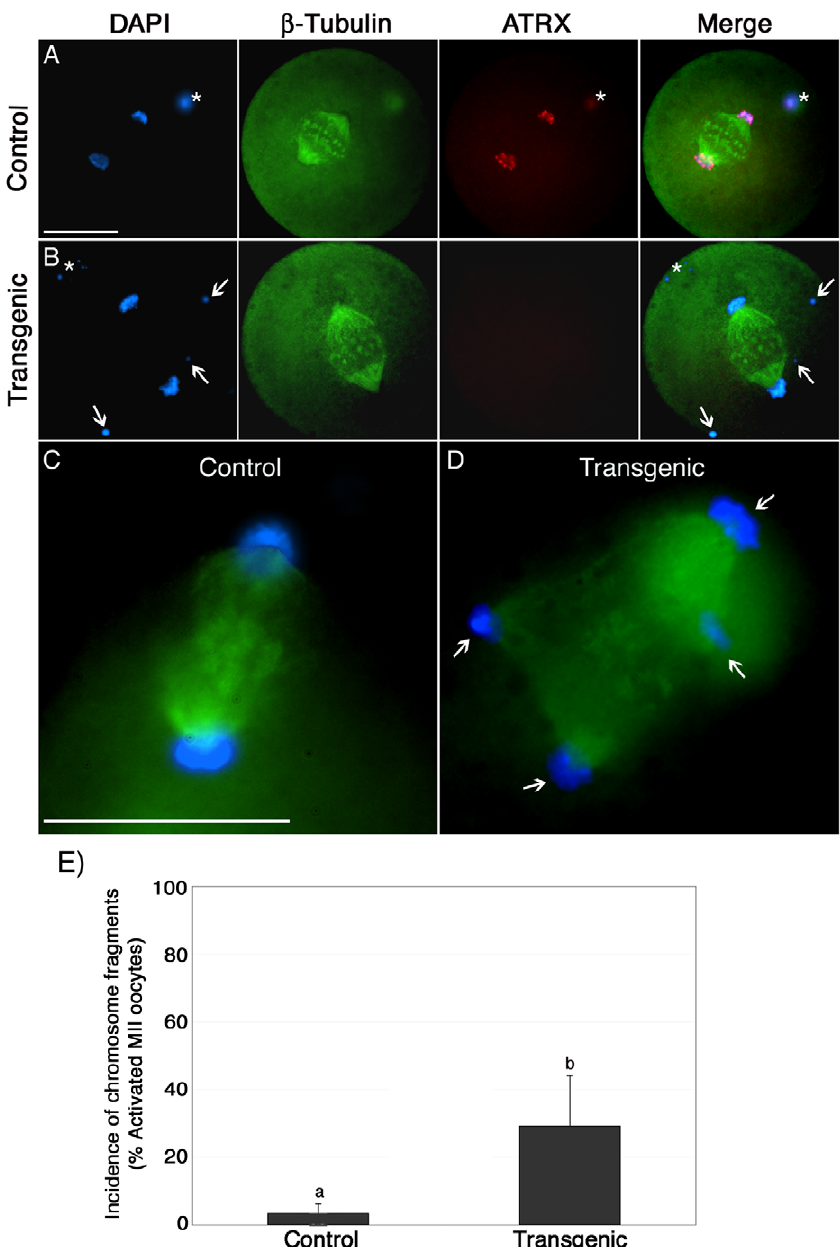
Figure 6. Chromosome fragmentation in ATRX deficient oocytes during the transition to the first mitosis. ( A ) Strontium chloride- activated control and ( B ) transgenic oocytes at late anaphase II stained with ATRX (red) and b -tubulin (green). Numerous chromosomal fragments (arrows) are evident in the transgenic oocyte. Asterisks indicate the position of the polar body. Scale bar =50 m m. ( D ) Transgenic oocyte with a multi- polar spindle (arrows, right image) and a control ( C , left image). Scale bar =10 m m. ( E ) Proportion of artificially activated oocytes presenting chromosome fragmentation. Data are presented as the mean 6 s.d. of three independent experiments.